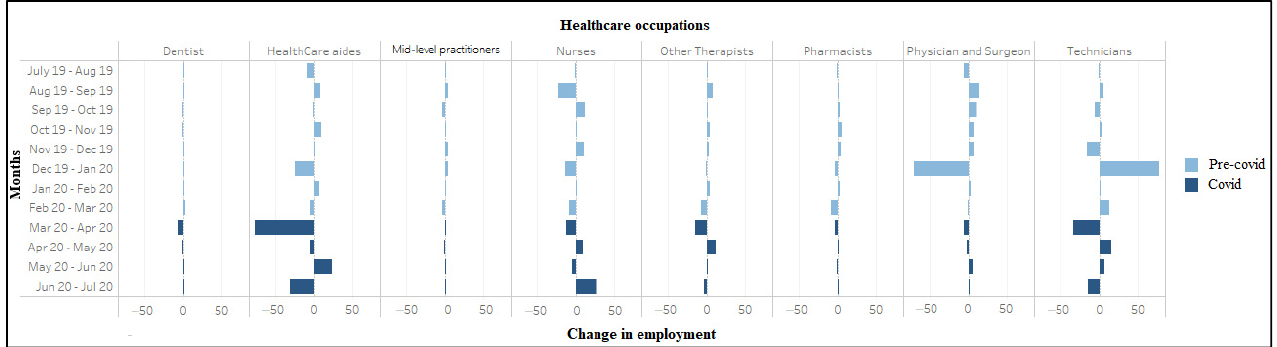
Figure 4. Change in employment (in ten thousand) among workers in healthcare occupations (July 2019–2020).